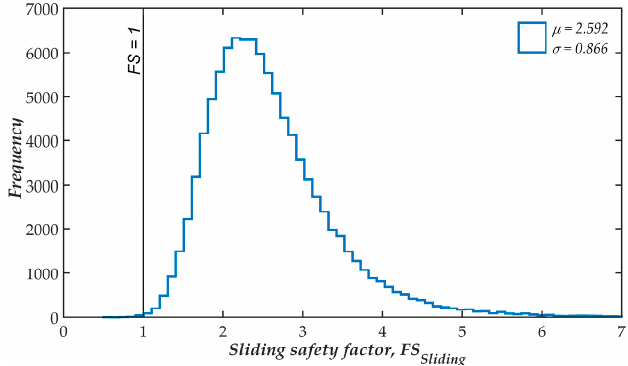
Figure 7. Histogram of the sliding safety factor in the case of Onsan breakwater.